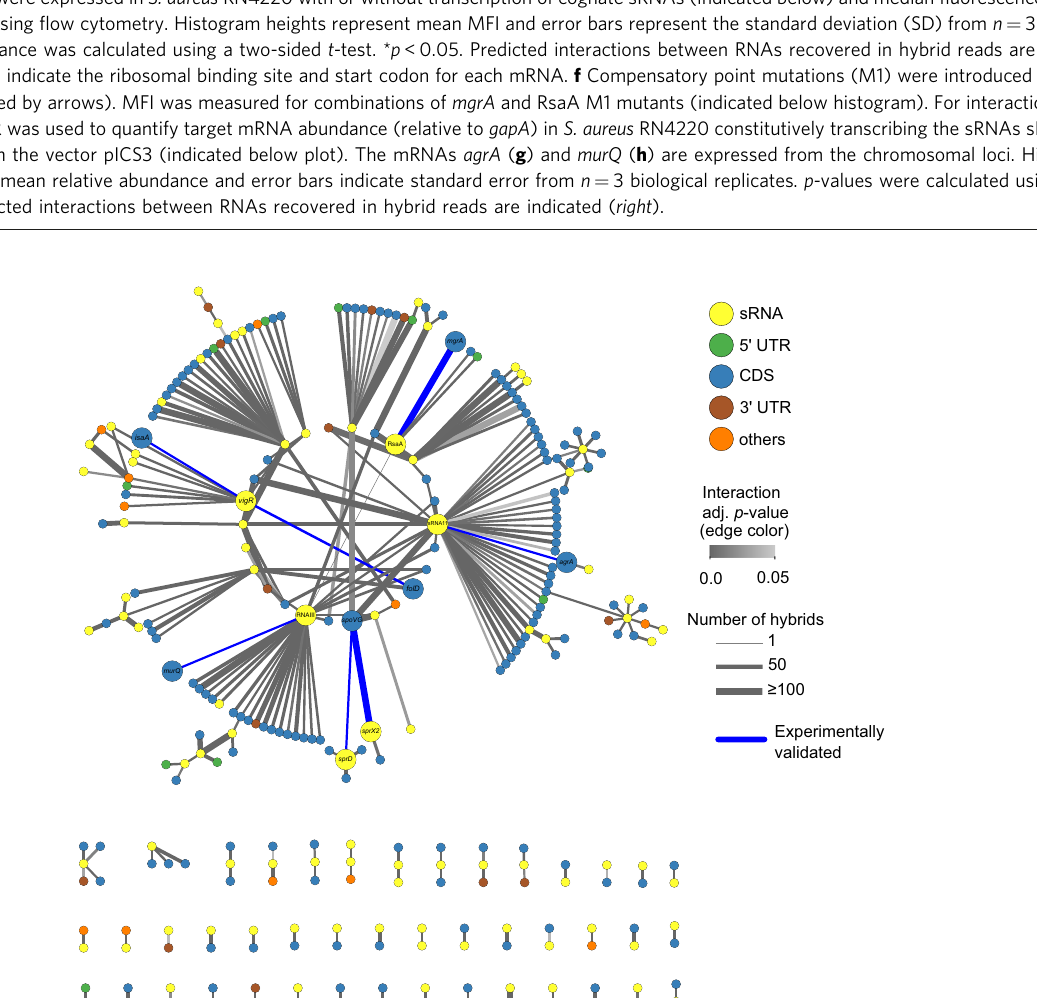
Fig. 3 Small RNA interactome of S. aureus JKD6009. Individual RNAs are indicated as nodes (circles) and coloured according to RNA class ( top right ). RNA – RNA interactions are indicated as edges (lines) and coloured according to FDR adjusted probability ( middle right ). The discrete probability P(X = n) of recovering each hybrid was modelled using a binomial distribution and combined between replicate experiments using the Fishers method. A detailed description of the statistical analysis performed on the RNase III-CLASH dataset is presented in Supplementary Methods. The line thickness of RNA – RNA interaction edges are weighted to indicate the number of hybrid reads captured for each interaction ( bottom right ). RNA – RNA interactions that are experimentally validated in the text are labelled at the node and edges are coloured (previously annotated as sRNA275) is required for vancomycin